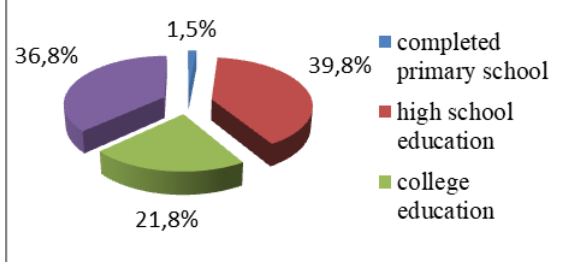
Figure 4. Sample structure by age